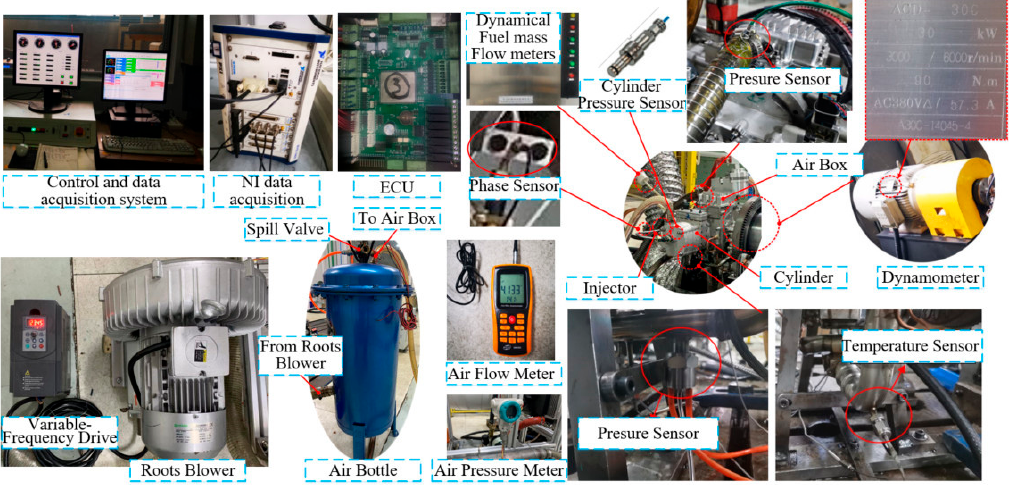
Figure 3. Modules of aircraft piston engine test system.